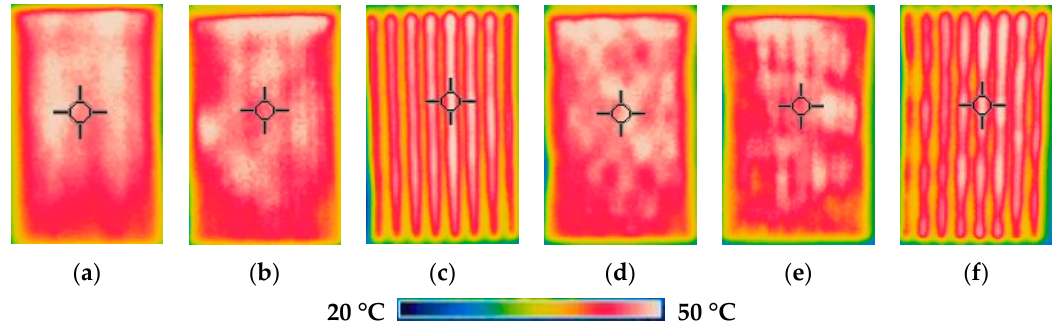
Figure 5. Thermal images of EFL1 ( a ), EFL2 ( b ), EFL3 ( c ), EFH1 ( d ), EFH2 ( e ), and EFH3 ( f ) structured electro-conductive fabrics after 10 min of constant voltage application.